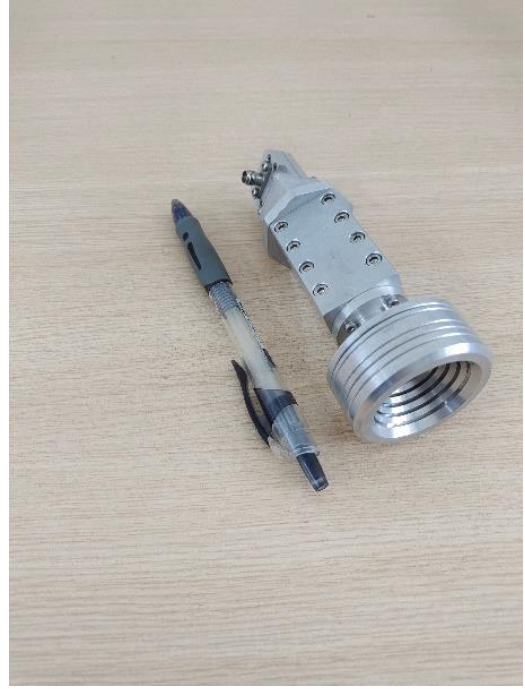
Figure 17. Photographs of the fabricated CP conical corrugated horn antenna. The simulated and measured reflection coefficients are shown in Figure 18. The measured − 10 dB impedance bandwidth was 52.7% covering from 17.2 to 29.5 GHz. The simulated − 10 dB impedance bandwidth was 61% covering from 17.1 to 32.8 GHz. The simulated maximum gain was 17.3 dBic at 31